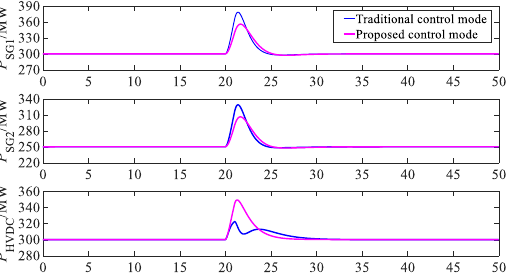
Figure 12. Output power of different sources in different control modes under short circuit fault.